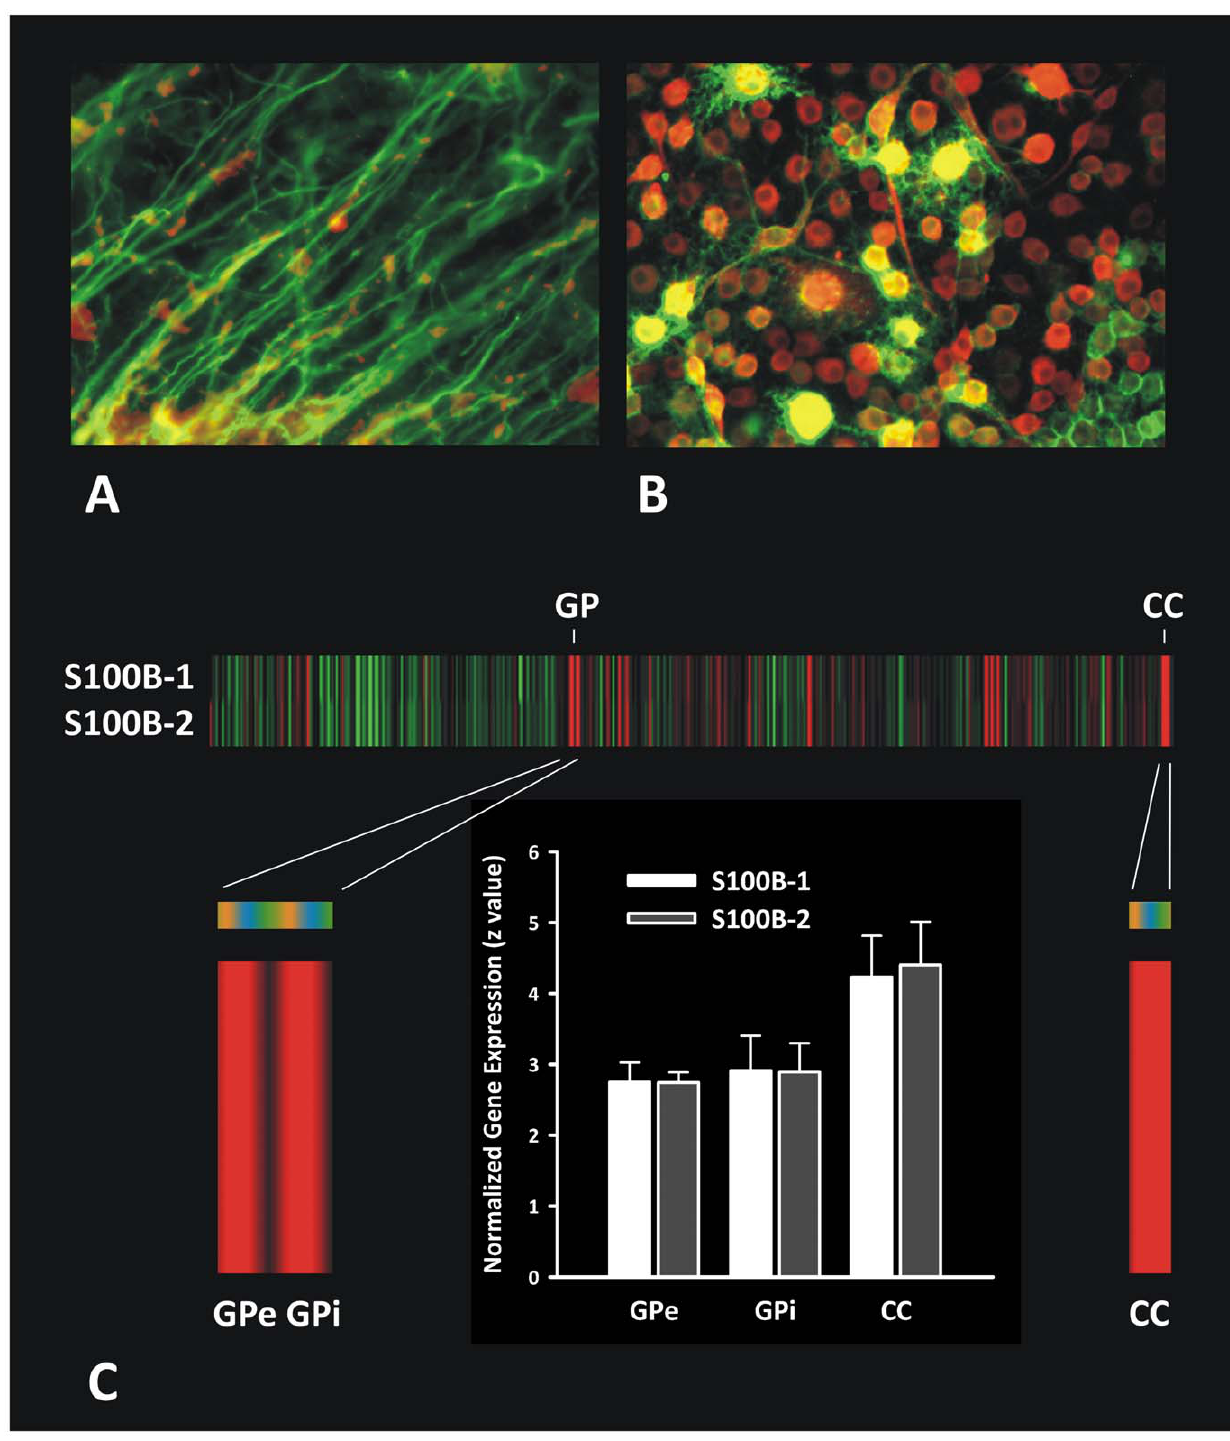
Figure 3. Expression and localization of S100B in the brain. (A) Co-localization (yellow) of S100B (red) and myelin basic protein (MBP)-positive (green) myelinated fibres in the human corpus callosum. Data originate from the subject previously published [6]. (B) Co-localization (yellow) between S100B (red) and the oligodendroglial marker p75 neurotrophin receptor (green) in the oligodendrocyte cell line OLN-93. (C) Individual normalized gene expression of S100B in heat map in z scores normalized to whole human brain expression, where green indicates relatively low and red relatively high expression. Subjects are coded in orange, blue and green (H351.2001,.2002 and.1009). Highest expression was detected in the corpus callosum (CC), followed by globus pallidus (GP). Bar chart shows quantitative values in CC and external/internal (e/i) GP (mean + standard deviation). Gene expression of S100B was analyzed in two probes: Probe 1 A_23_P143526; Sequence: AGCTTGATTTGCTTTGTGATTGAAAAATT- GAAAACCTCTTTCCAAAGGCTGTTTTAACGG; Probe 2 CUST_17042_PI416261804; Sequence: AAGCTGAAGAAATCCGAACTGAAGGAGCTCATCAACAAT- GAGCTTT CCCATTTCTTAGAG.